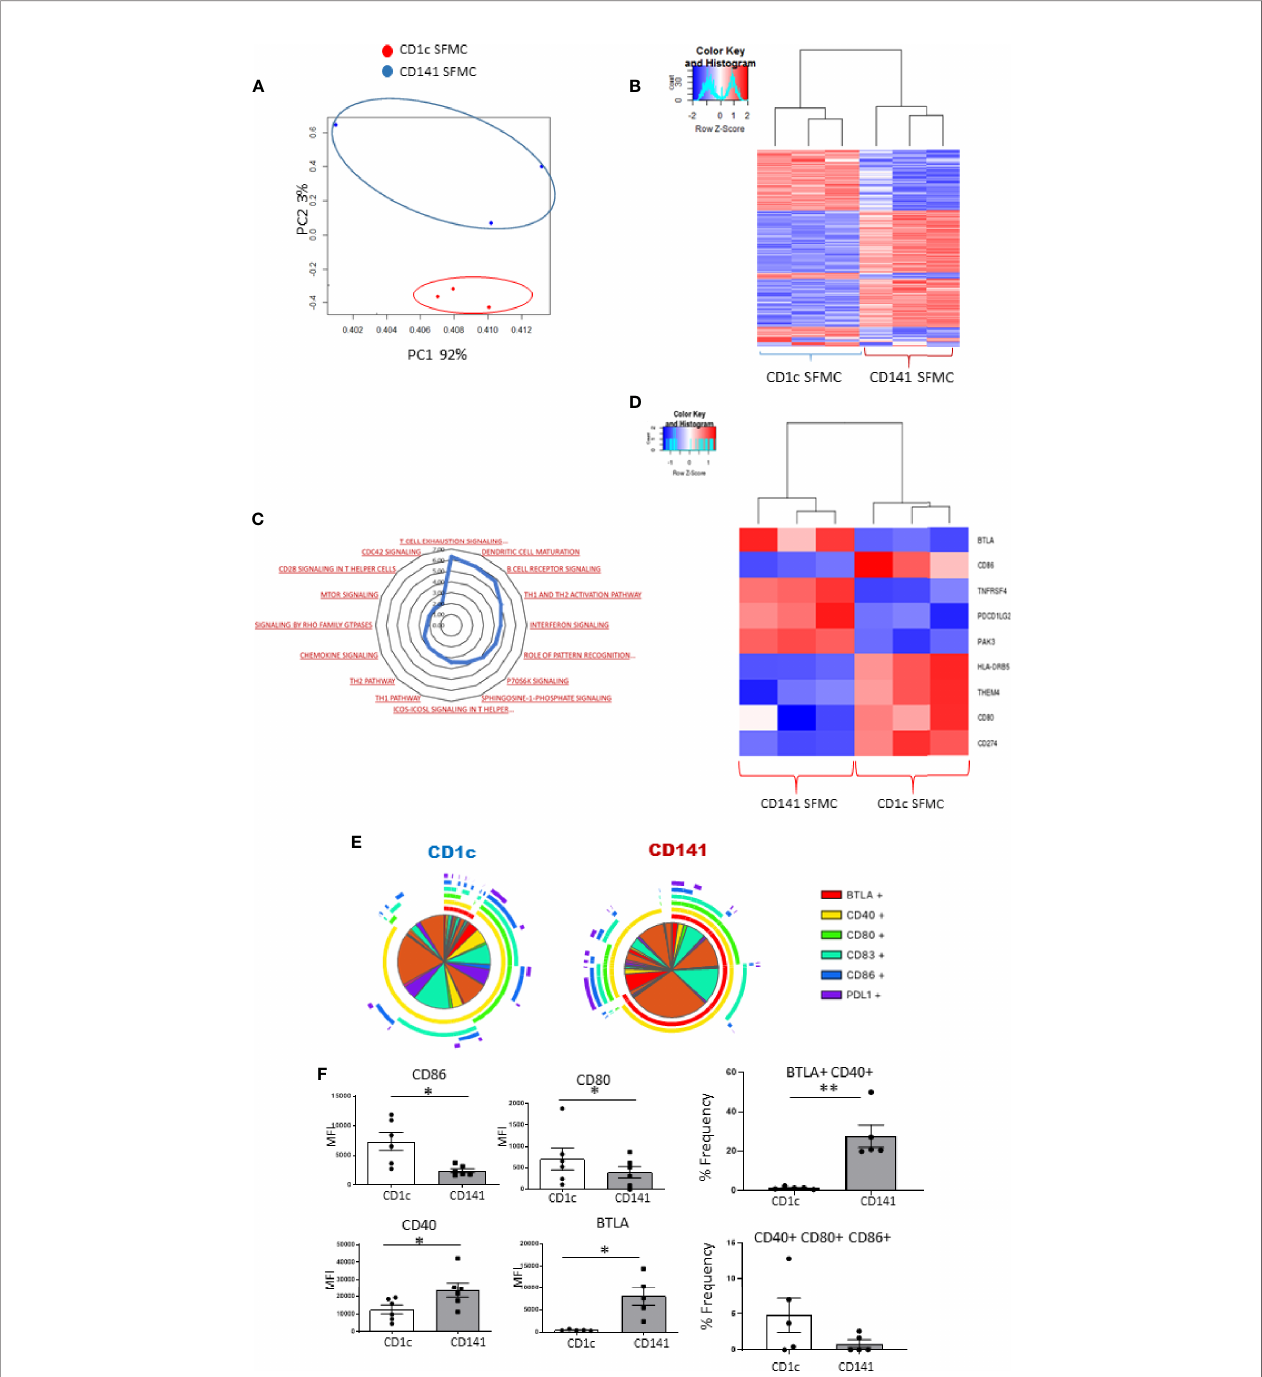
FIGURE 5 | Synovial CD1c+ DCs and Synovial CD141 + DCs have differential costimulatory marker expression: (A) RNA sequencing was performed on SF CD1c + DCs and SF CD141 + DCs (n = 3). PCA of total datasets from SF CD1c+ DCs and SF CD141 + DCs. Hierarchical clustering analysis on DEG from SF CD1c + DCs and SF CD141 + DCs. (B) Hierarchical clustering on the DEGs from SF CD1c + DCs and SF CD141 + DCs. (C) Radar plot representing enriched pathways in SF CD1c + DCs compared to SF CD141 + DCs using IPA. (D) Clustered heatmap representing DEGs involved in DC maturation from SF CD1c + DCs and SF CD141 + DCs. (E, F) Heatmap coded pie charts demonstrating the co-expression pro fi le of DC maturation markers on SF CD1c + DCs and SF CD141 + DCs. Each section of the pie chart indicates different combinations of maturation marker expression. The pie chart arcs indicate the maturation markers expressed by each proportion of cells. (F) MFI of CD86, CD80, CD83, CD40, BTLA, and PD-L1 on SF CD1c + DCs and SF CD141 + DCs (n = 5). Percentage frequency of the most differentially distinct co- expression patterns from the SPICE analysis on SF CD1c+ DCs and SF CD141 + DCs (n = 5). Non-parametric unpaired Mann Whitney test was used. *p < 0.05 indicates groups that are signi fi cantly different from each